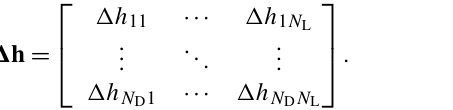
Figure 3. PVC pipe cost from 2011 data.